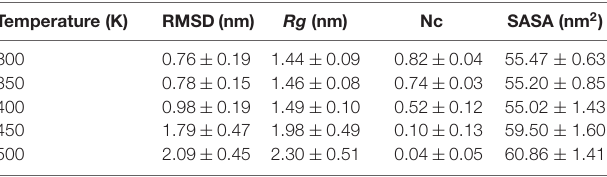
TABLE 1 | Structural order parameters (average ± standard deviation) obtained from MD simulations of NTD unfolding in the presence of 8 M DMSO at different